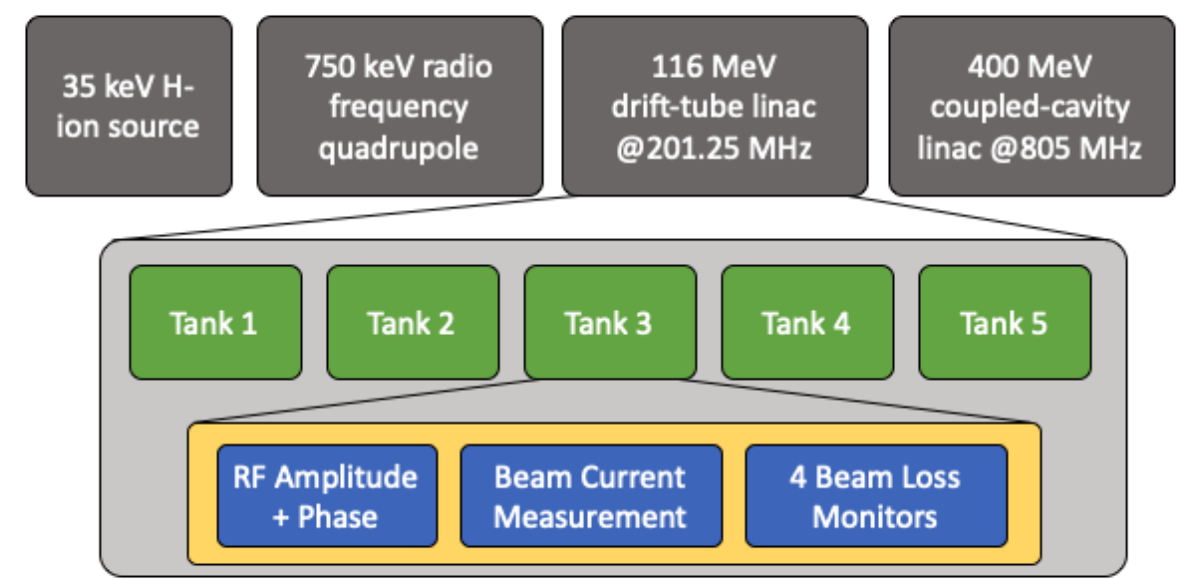
Figure 4. Hierarchical schematic of the Fermilab